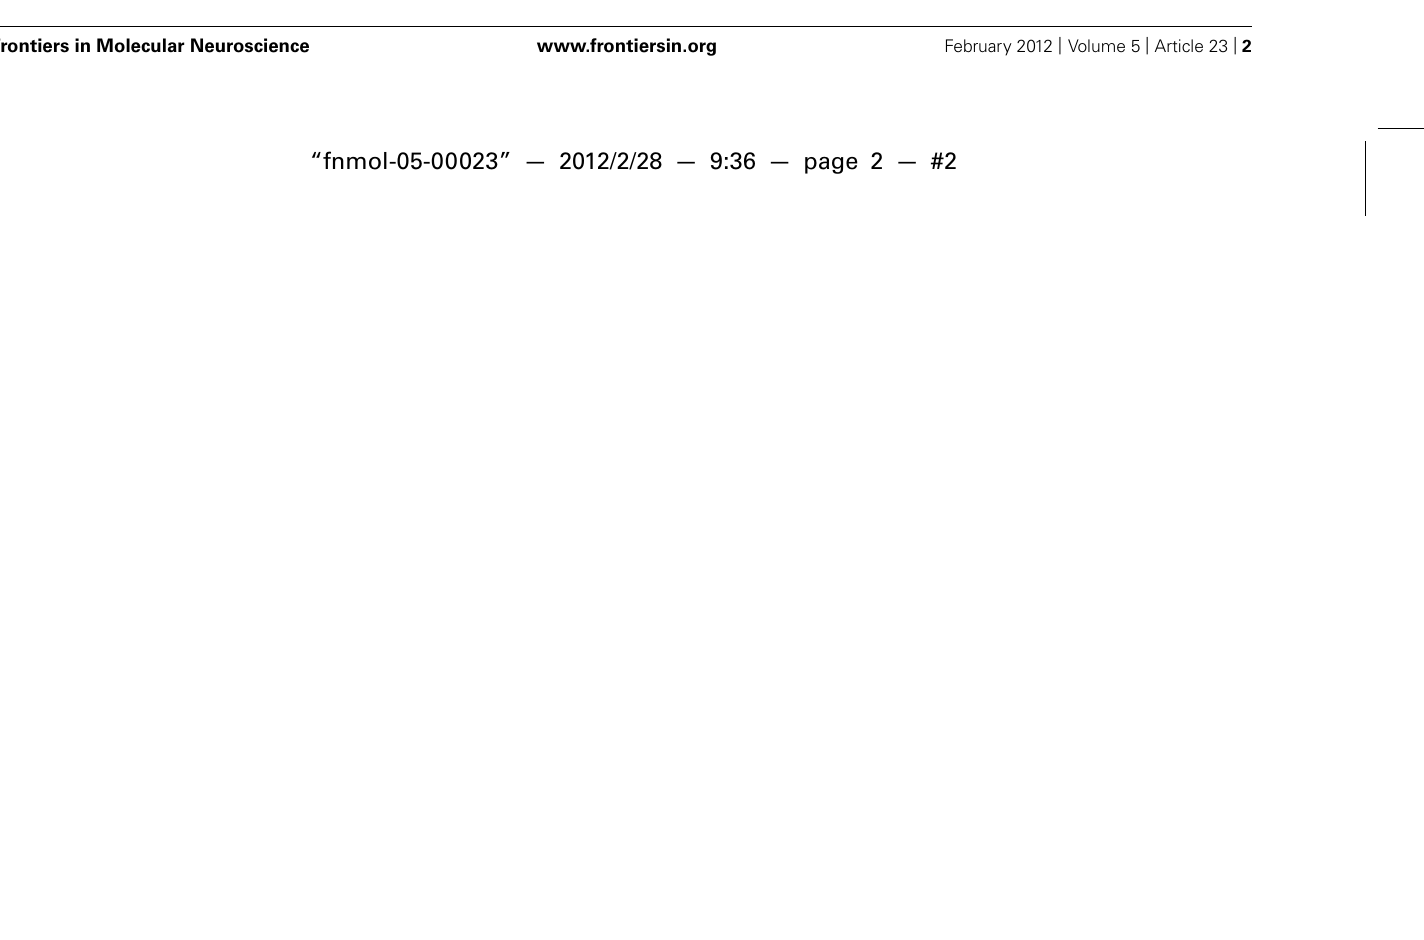
FIGURE 1 | Evolutionary progress of the clock and metaplasticity. Upper : In early life, recurring environmental stimuli would set up a biological timing mechanism that involves an autoregulatory feedback loop, which would be integrated with metabolic processes.These in turn would lead to behavioral output processes that optimize chances for survival, through gating the organism to appropriate environmental niches. Lower :This process would become much more refined over evolutionary time, such that environmental oscillators which occur on regular frequencies would render the timing mechanism some resistance to change, such that in the absence of the